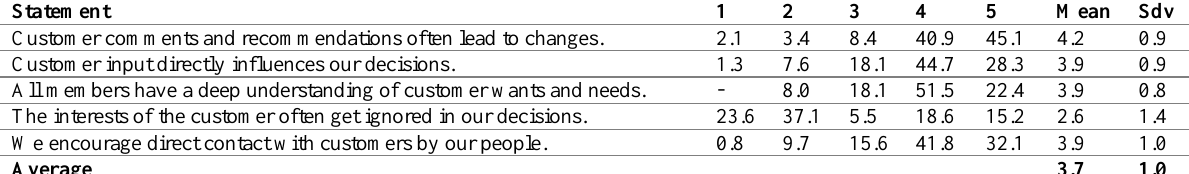
Table 6: Subordinate staff’ Perception on Vision of their Respective